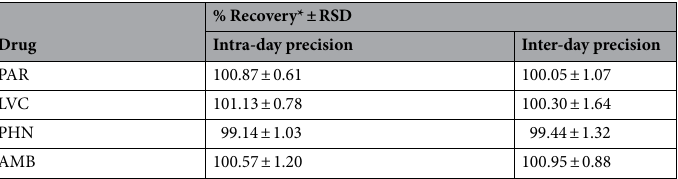
Table 3. Evaluation of intra- and inter-day precision of the analytical procedure of the studied drugs (50, 5.0, 5.0 and 10 μg/mL of PAR, LVC, PHN and AMB, respectively).